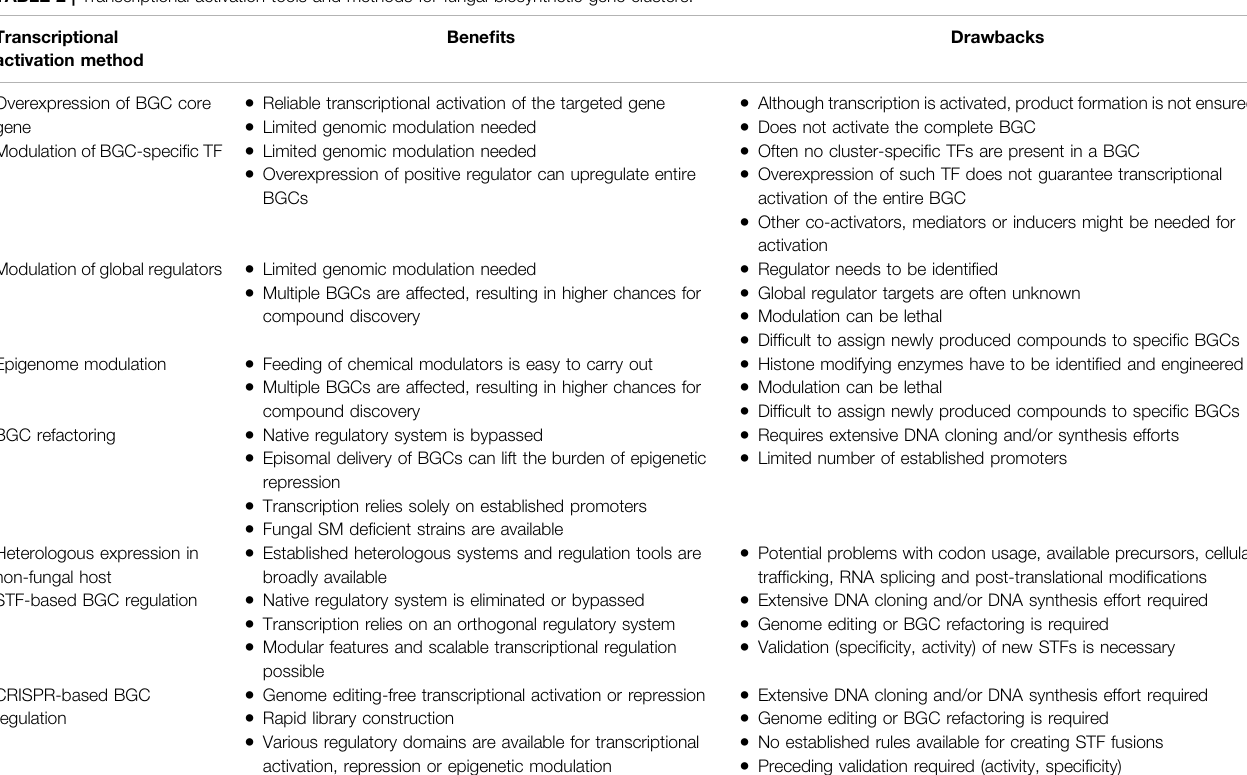
TABLE 2 | Transcriptional activation tools and methods for fungal biosynthetic gene clusters. Transcriptional activation